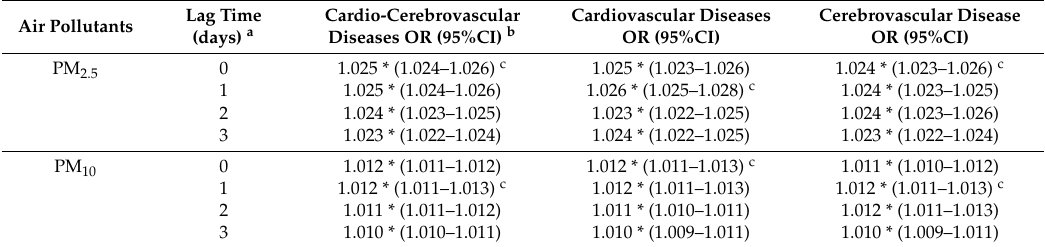
Table 3. OR value of cardio-cerebrovascular disease mortality associated with 10 µ g/m 3 increase of PM 2.5 and PM 10